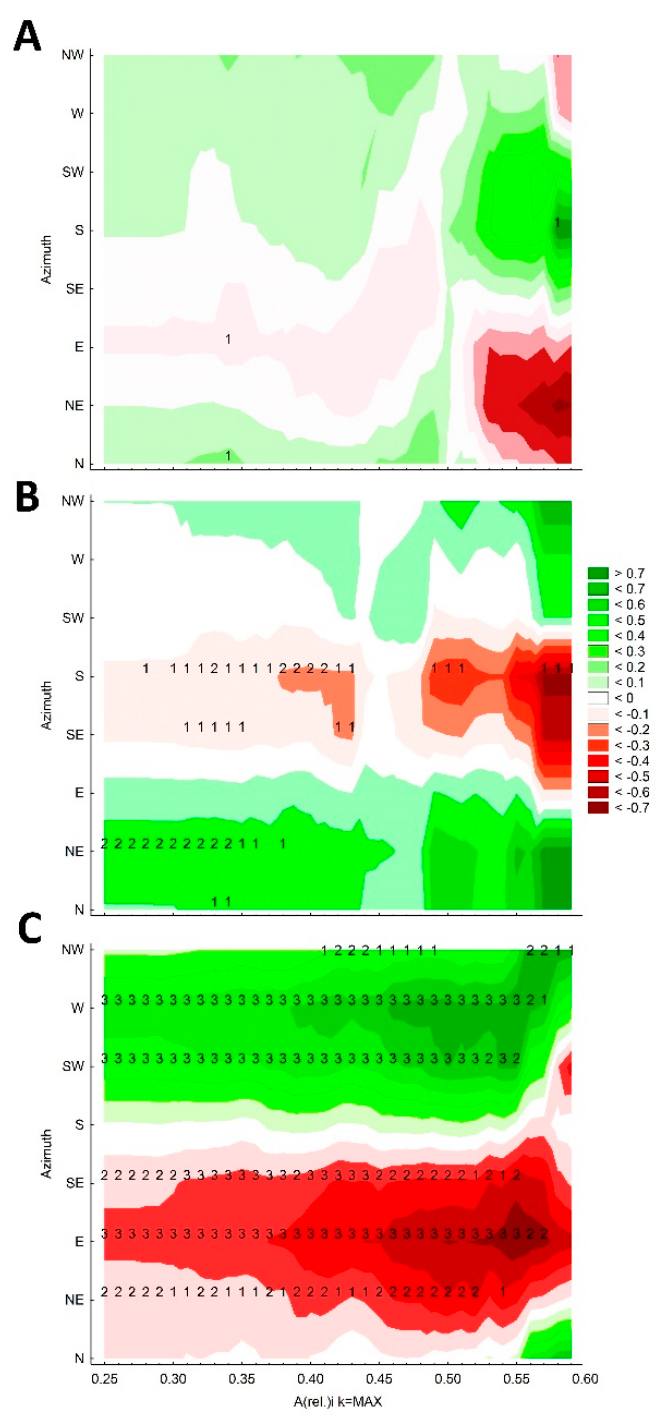
Figure 8. The Pearson’s correlation coefficients ( R ) of linear regressions between relative 5-year radial increments (I5 r ) and the orientation of the largest relative sector (largest AS rk ) for dominant ( A ), co-dominant ( B ) and sub-dominant trees ( C ). The numbers 1–3 indicate the significance of the correlation on a significance level of α = 0.10 (1), α = 0.05 (2) and α = 0.01 (3).